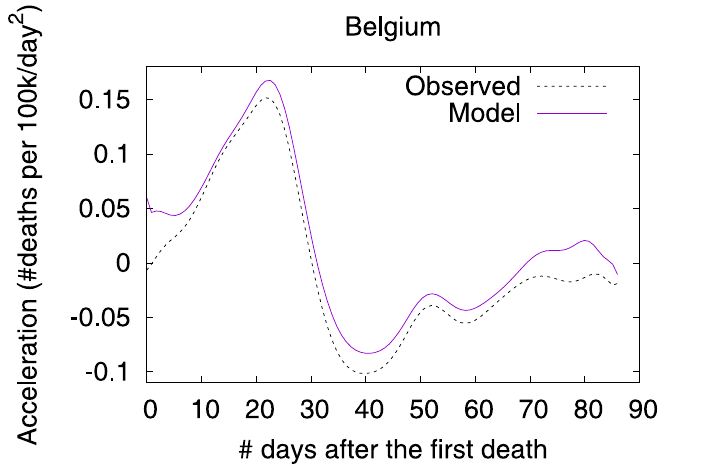
Fig 32. (Color online) projections for acceleration in